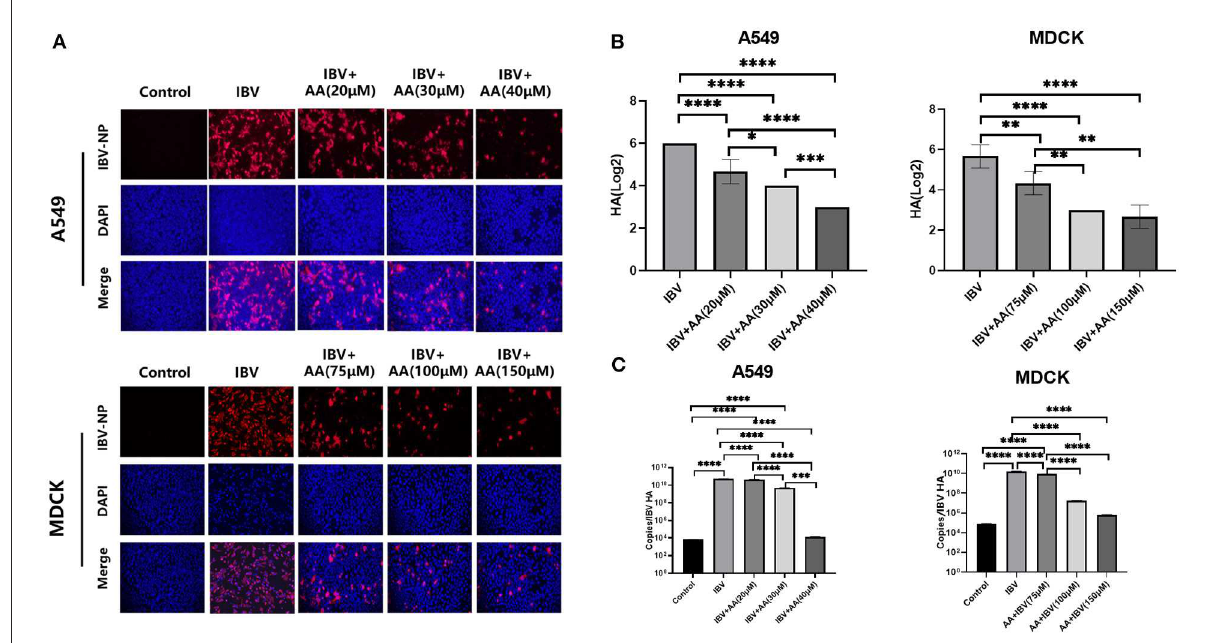
FIGURE2 Antiviral effects of Atractyloside A against IBV infection in vitro . MDCK and A549 cells were infected with 0.1 MOI of IBV and treated with various concentrations of AA for 24h. (A) Immunofluorescence analysis of the expression of IBV nucleoprotein after infection. Hemagglutination test (B) and virus copy number detection (C) after IBV infection. The results are presented as mean ± standard deviation (* p < 0.05, ** p < 0.01, *** p < 0.001, and **** p <